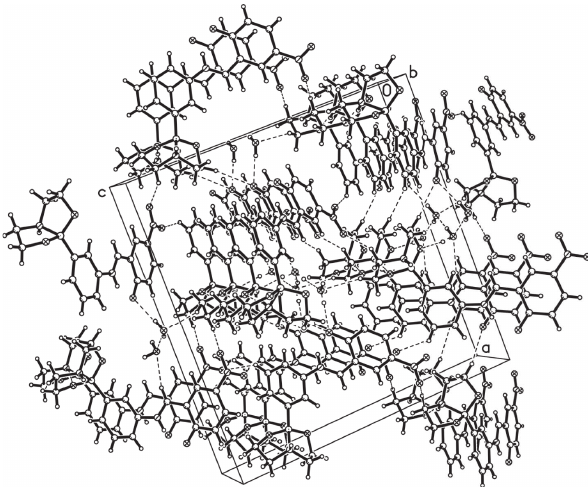
Figure 1: The packing diagram of the title compound, showing supramolecular